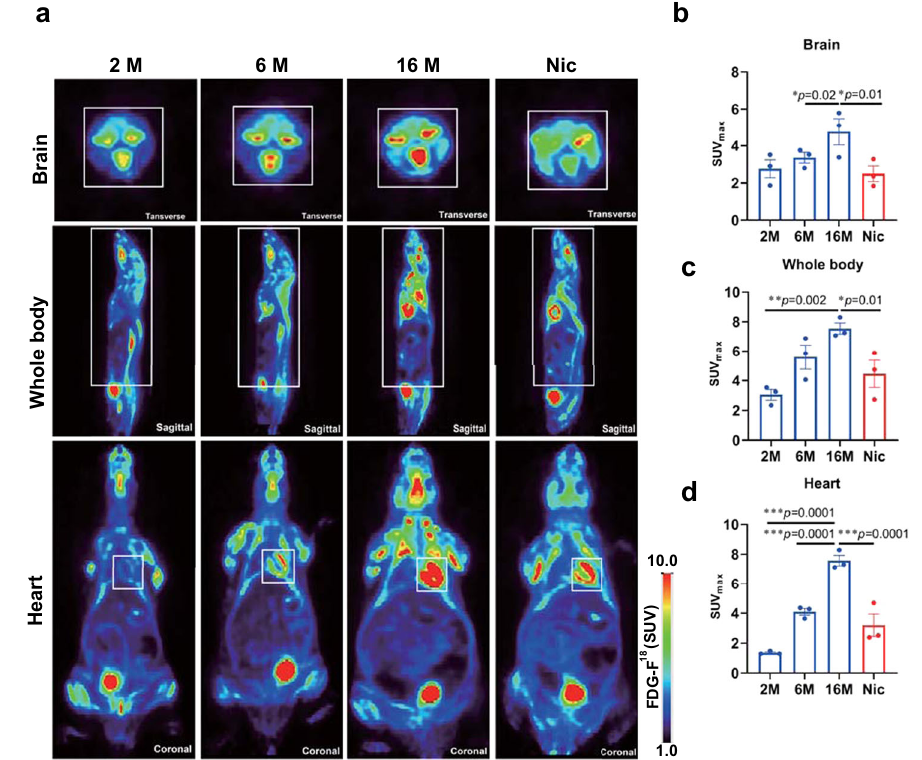
b – d PlotsshowthetissuesSUVof 18 F-FDG.Dataaremeans±SEM( n =3,biologically independentsamples/group). p valuesweredeterminedbyoneANOVAwithTukey post hoc correction ( b – d